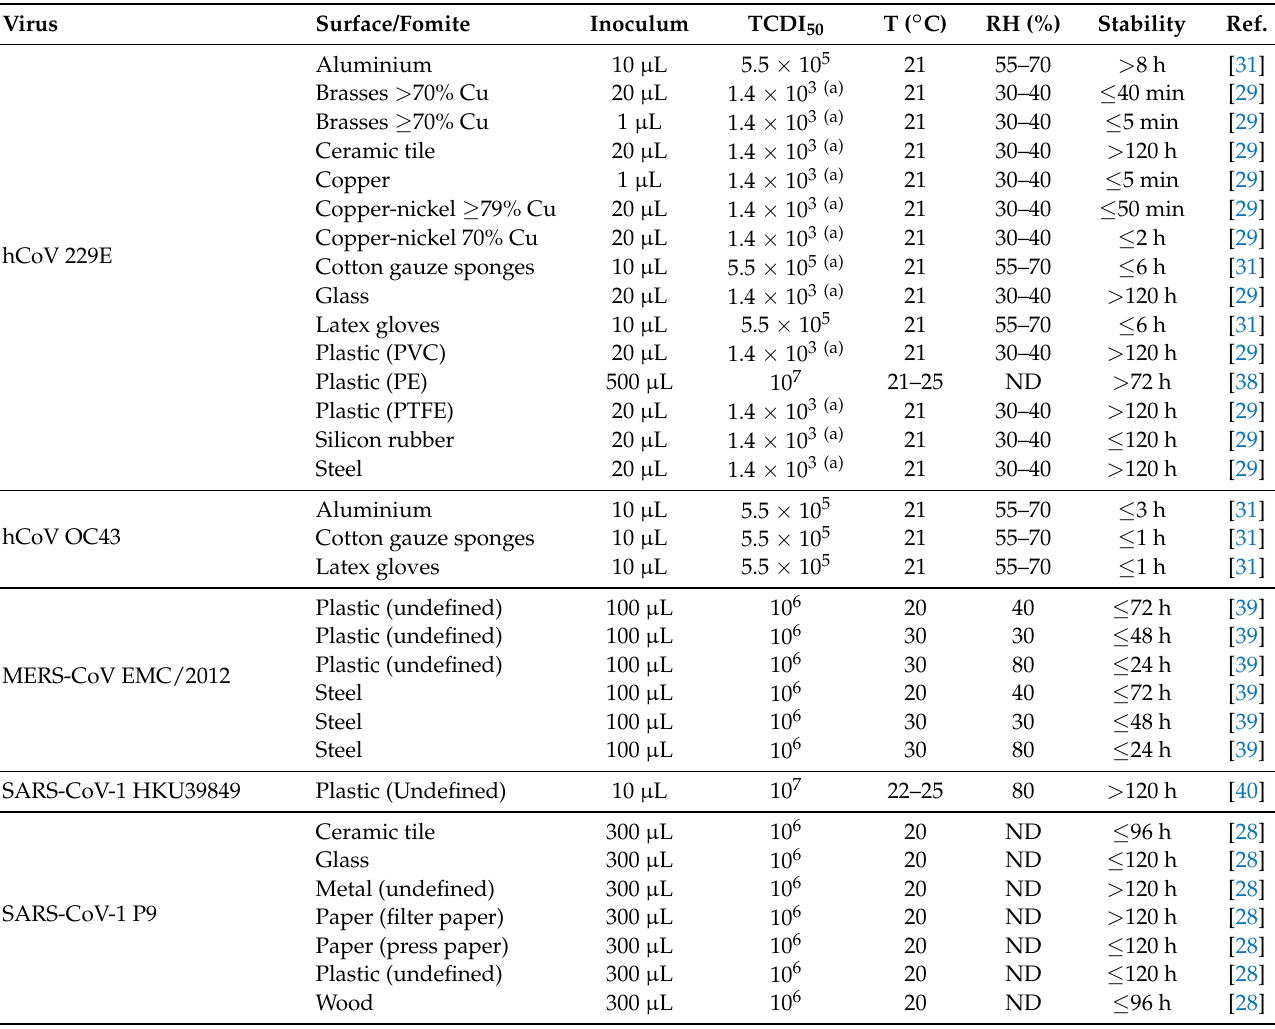
Table 1. Persitence time of SARS-CoV-1, SARS-CoV-2, MERS-CoV and hCoV over different surfaces. TCDI50: Median tissue culture infectious dose, RH: relative humidity, ND: not defined, PVC: polivynil chloride, PE: polyethylene, PTFE: polytetrafluoroethylene, PP: polypropropylene, RC: room conditions. (a) : Calculated from plaque forming units (PFU) following the instructions (1 TCID 50 ≈ 0.7 PFU) reported by the American Type Culture Collection (ATCC). (c) : Personal communication from the